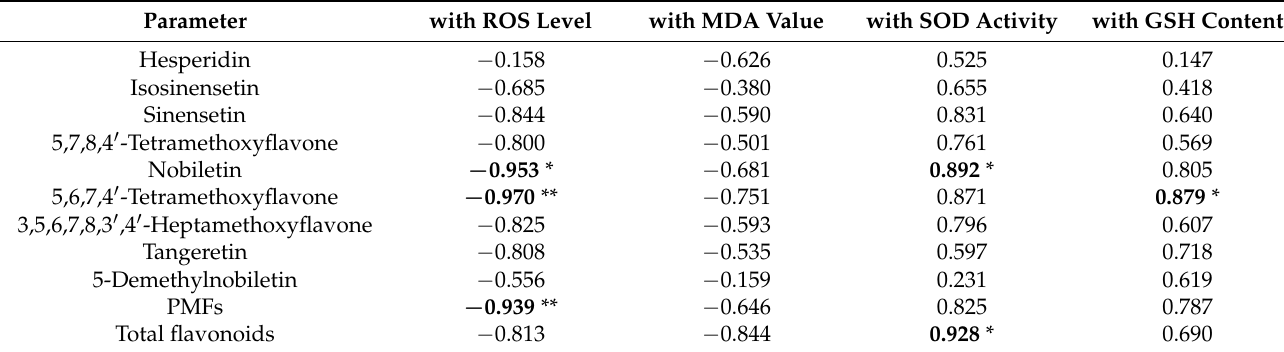
Table 5. Pearson correlation coefficient